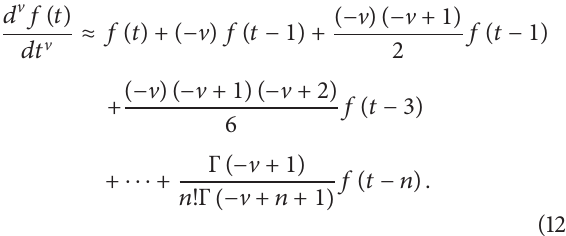
Figure 5: Results of corner extraction using the adaptive fractional differentiation Harris corner detection